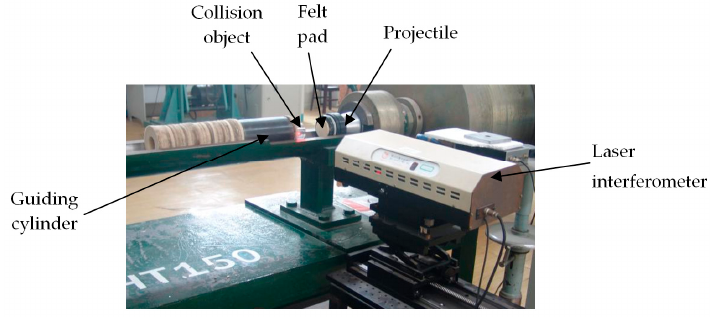
Figure 6. Photo of the projectile before collision with the collision object.